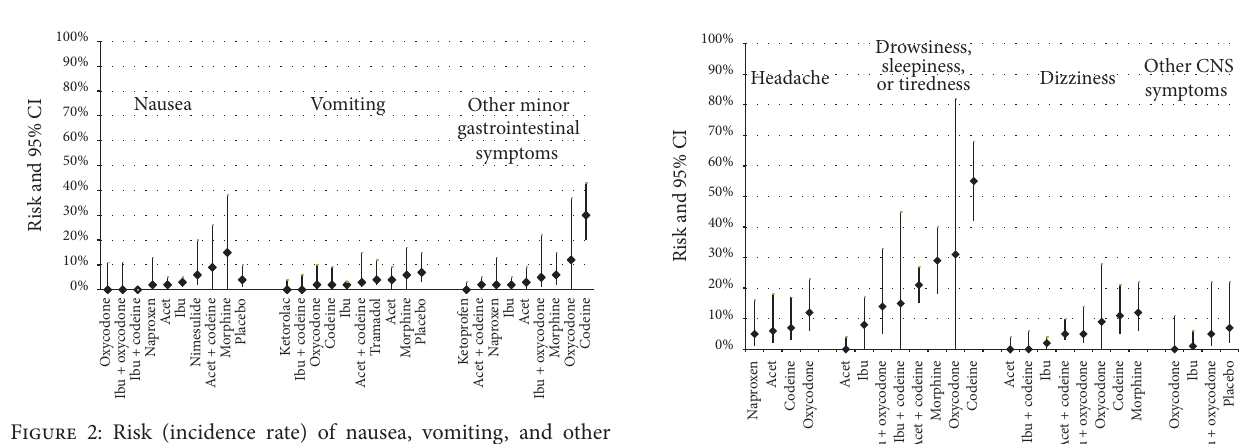
Figure 2: Risk (incidence rate) of nausea, vomiting, and other minor gastrointestinal symptoms by medication. ∗ Other minor gastrointestinal (GI) symptoms included diarrhea, gastric pain, pills being hard to swallow, feeling sick, being unwell with vomiting and reduced urine output, emesis, constipation, sore stomach and abdominal pain, dry mouth, and unspecified GI symptoms. Acet = acetaminophen; ibu = ibuprofen. Results are presented in lowest to highest risk order with placebo at the end (where data were available).